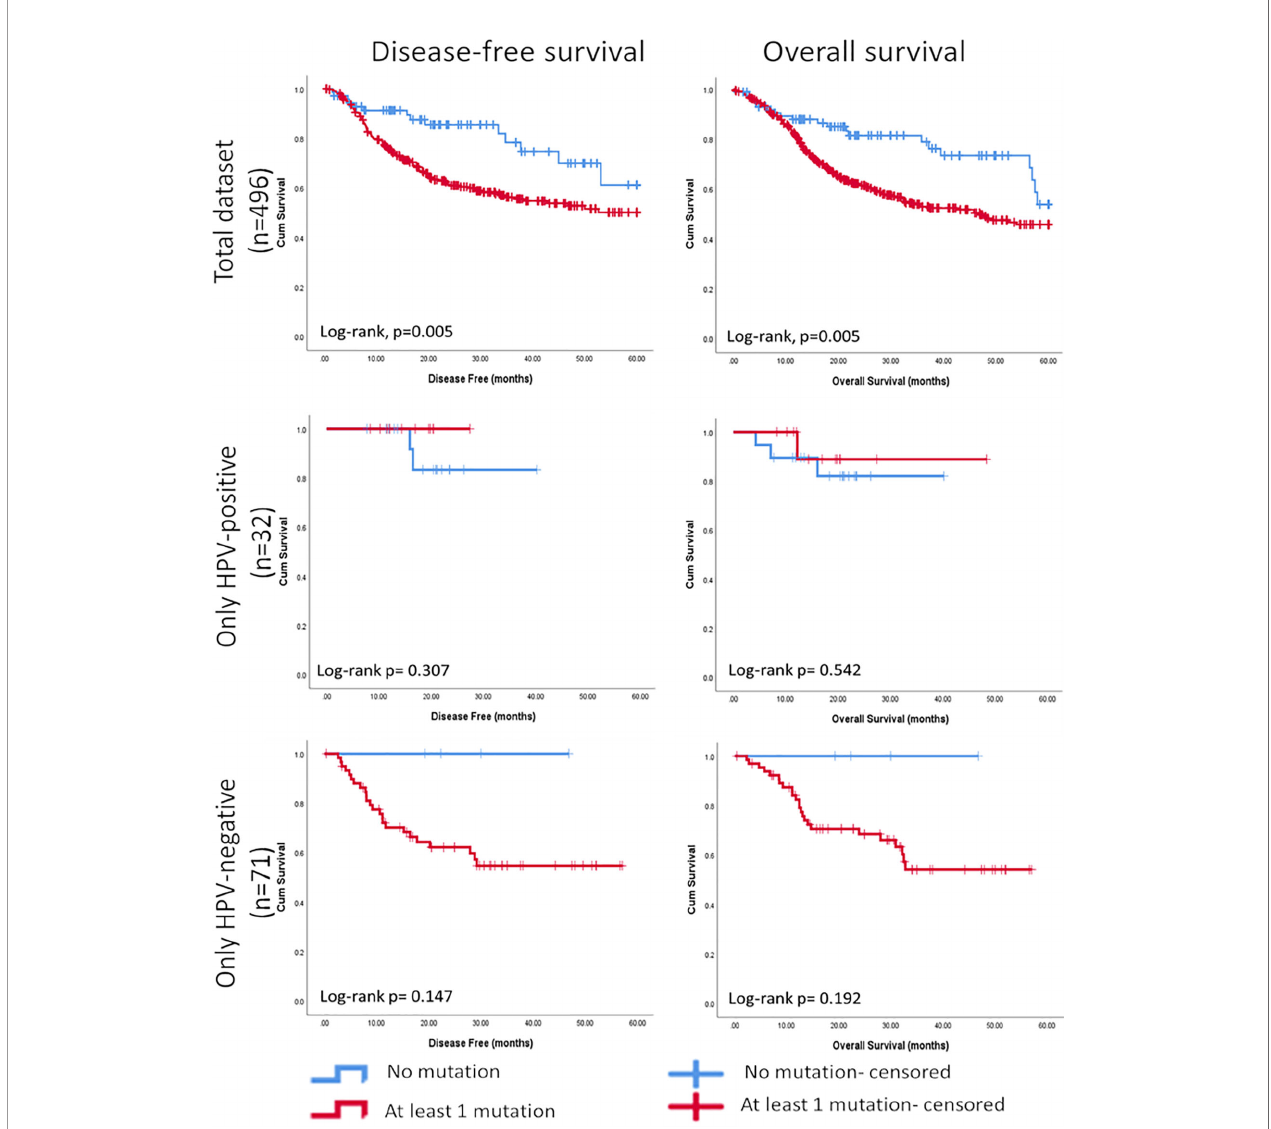
FIGURE 7 | Kaplan-Meier curves showing signi fi cant associations between the mutational score based on seven cancer-speci fi c genes found most frequently mutated in HNSCC and further strati fi ed based on HPV-status using the targeted NGS panel and disease-free survival (5 years) and overall survival (5